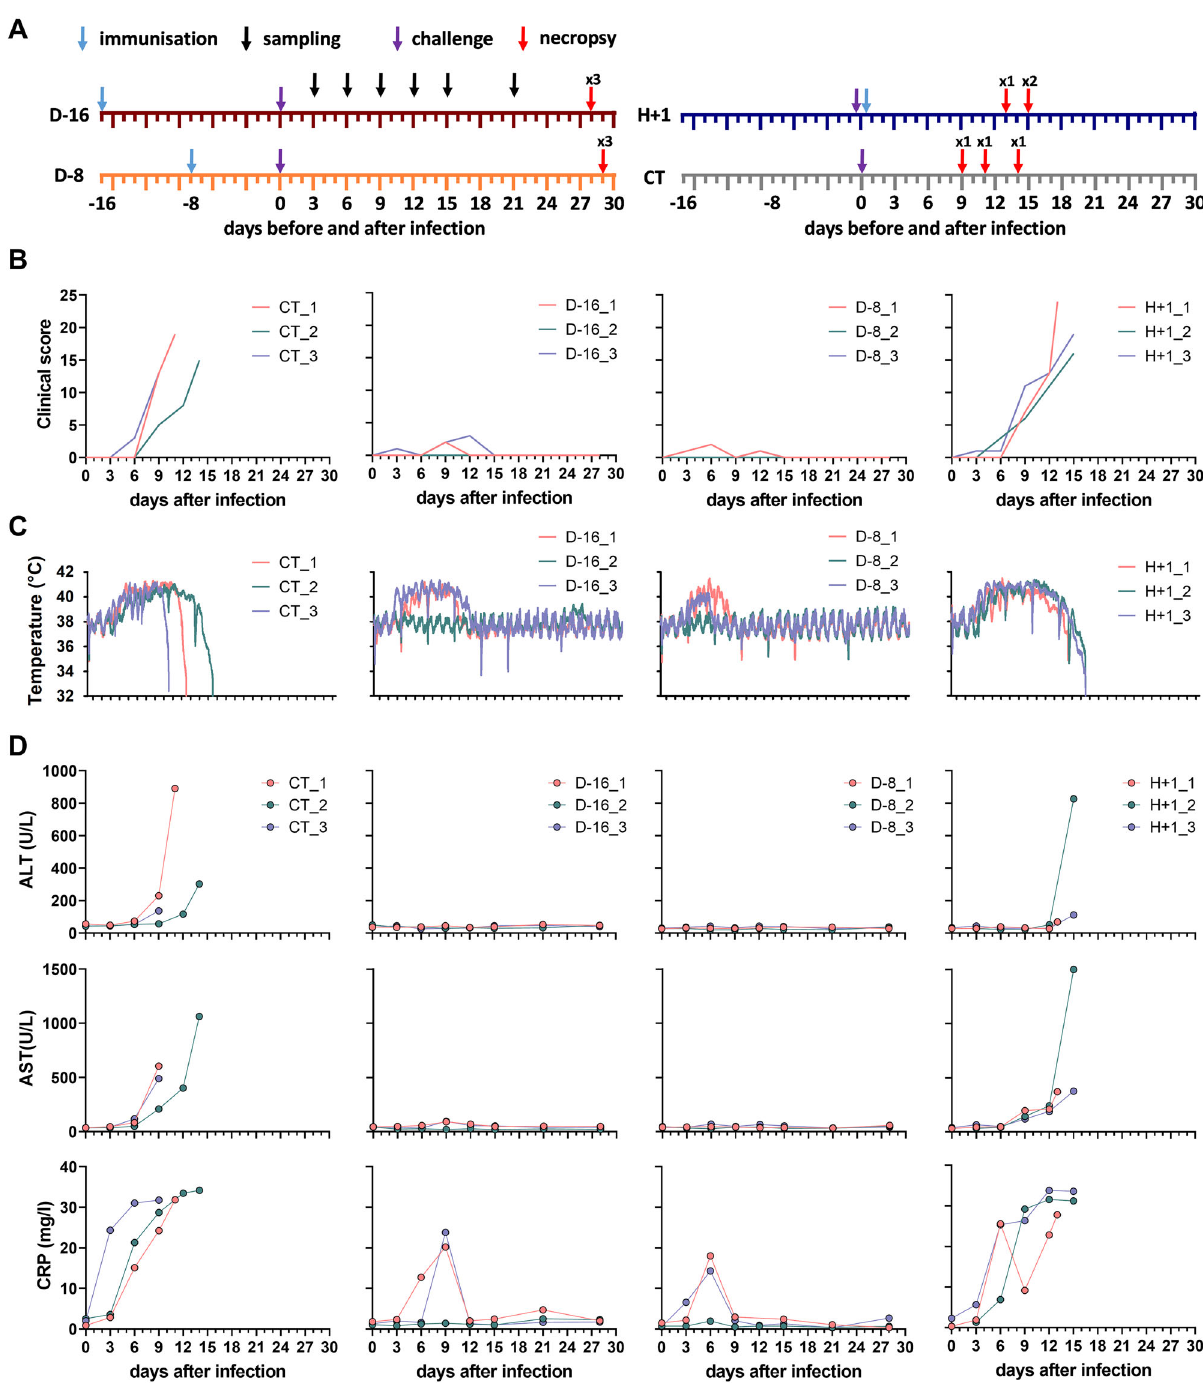
Fig. 1 | Short-term immunization of cynomolgus monkeys with MeV-NP pro- tects against Lassa fever. A Outline of the experiment. Scheme presenting the three animal groups with MeV-NP immunizations indicated by blue arrows, LASV challengebypurplearrows,samplingbyblackarrows,andnecropsybyredarrows, with the number of necropsies indicated above the arrows. D-16: animals immu- nized withMeV-NP16daysbeforechallenge.D-8:animalsimmunizedwithMeV-NP 8daysbeforechallenge.H+1:animalsimmunized